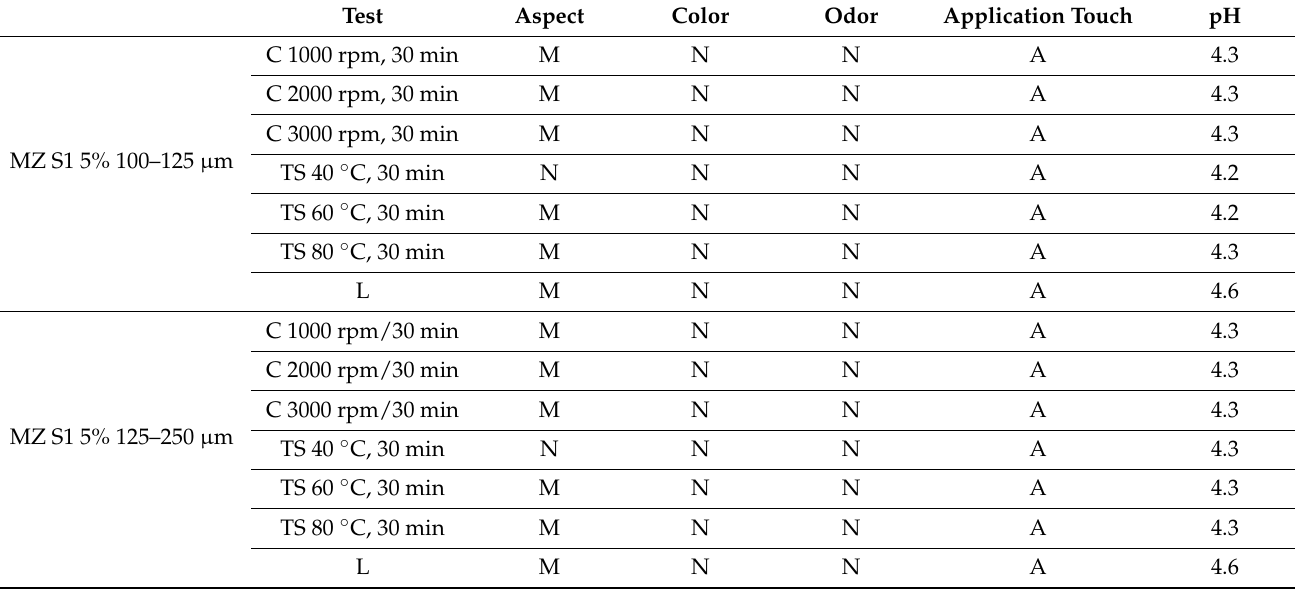
Table 5. Organoleptic characteristics and pH values of the cosmetic formulations in the preliminary stability